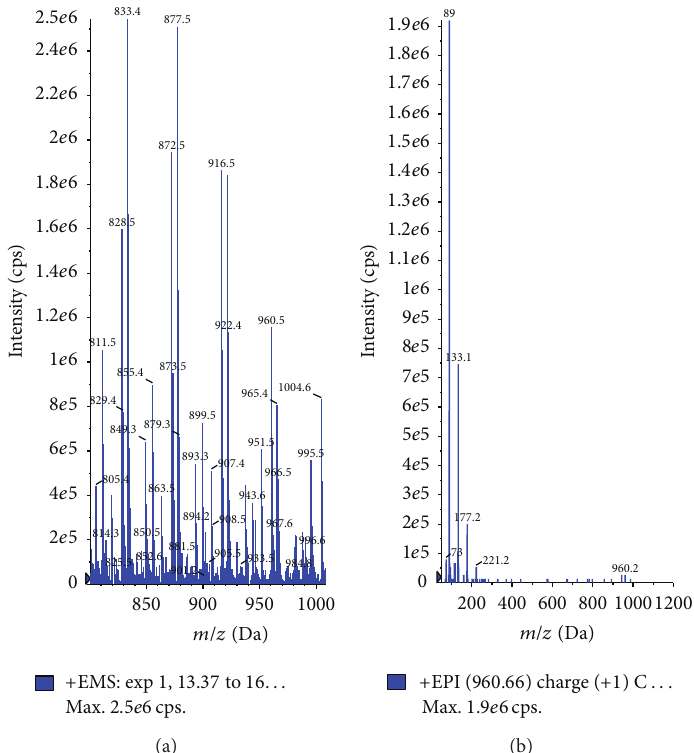
Figure 3: (a) Parent ion scan representing the molecular ions of PEG oligomers of CrEL. (b) Fragmentation pattern of selected oligomer with m/z